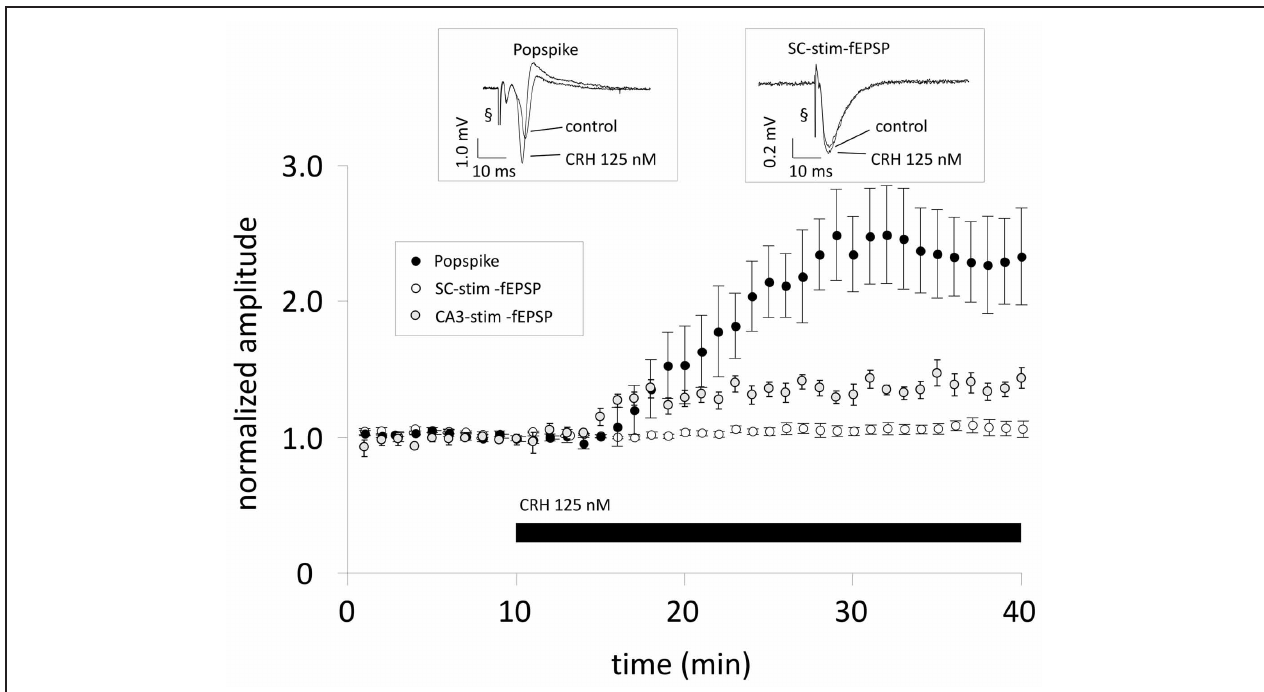
FIGURE 1 | When Schaffer-collaterals are electrically stimulated CRH increases the population spike (PS) amplitude without affecting field excitatory postsynaptic potentials (fEPSPs). Acute sagittal hippocampal brain slices were obtained from male CD-1 mice (P30–P50). Dual recording was performed by positioning one electrode in the stratum radiatum of the CA1 region for monitoring fEPSPs (SC-stim-fEPSPs; white symbols) and the second electrode was positioned in the pyramidal layer for monitoring PS (black symbols). After 10min of reaching a stable baseline, CRH (125nM) was applied to the perfusion medium. CRH increases PS amplitudes to 231 . 8 ± 31 . 2% of baseline level ( n = 10; p < 0 . 05) without affecting fEPSP slope (104 . 3 ± 4 . 2% of control; n = 10; p > 0 . 05). In a subset of experiments